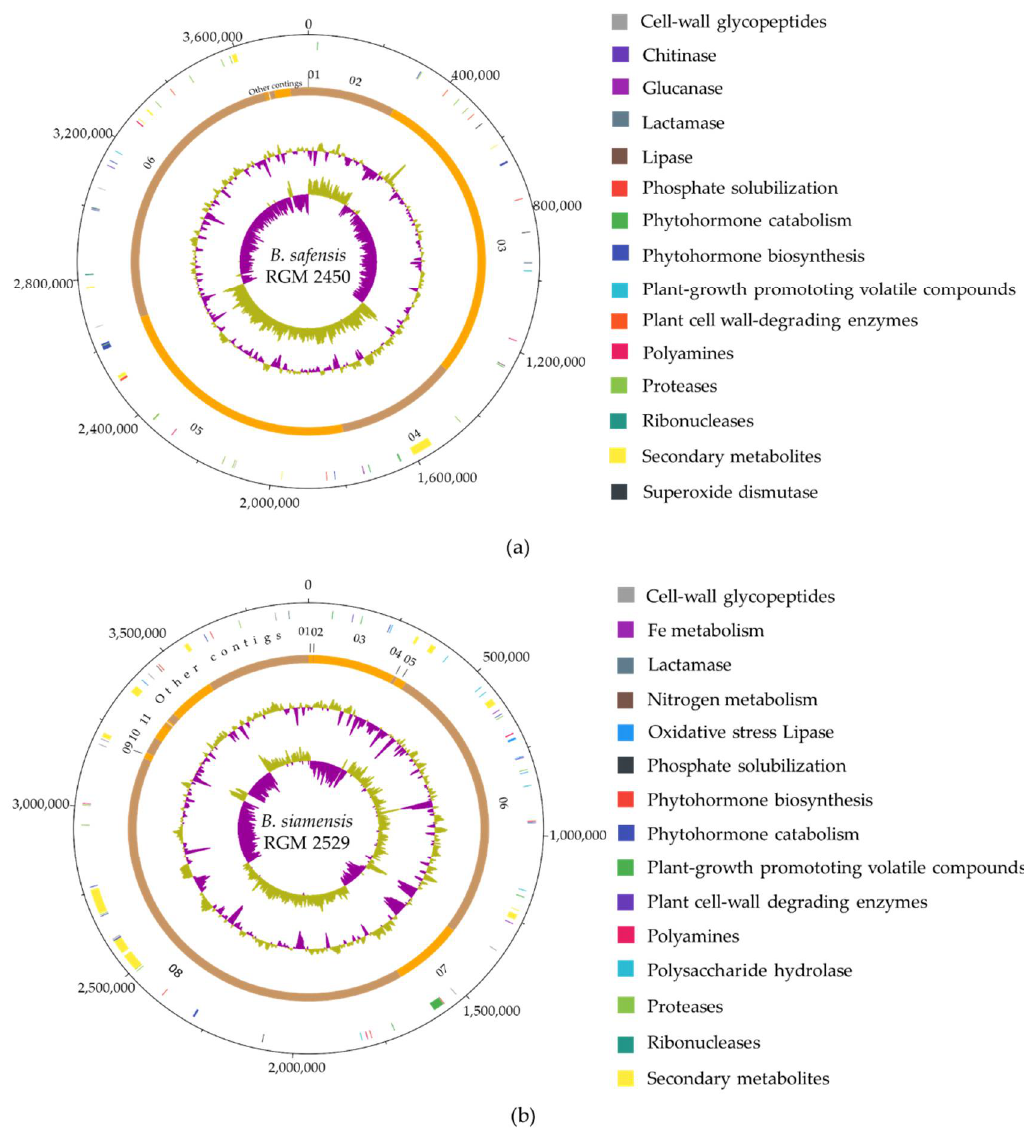
Figure 1. Circular representation of the PGPR bacterial strain genomes. ( a ) B. safensis RGM 2450. ( b ) B. siamensis RGM 2529. Tracks from outside to inside: circle 1, nucleotide base position (bp) clockwise starting from zero; circle 2, biosynthesis gene clusters or extracellular enzymes genes detected are indicated by colored regions; circle 3, position of DNA contigs, light orange = odd-numbered contigs, dark orange = even-numbered contigs; circle 4, G + C nucleotide content plot, using a 10 kb window size, lime/purple peaks indicate values higher/lower than aver-age G + C content, respectively; circle 5, GC skew plot [(G − C)/(G + C)], using a 10 kb window size, lime/purple peaks indicate values higher/lower than 1, respectively.